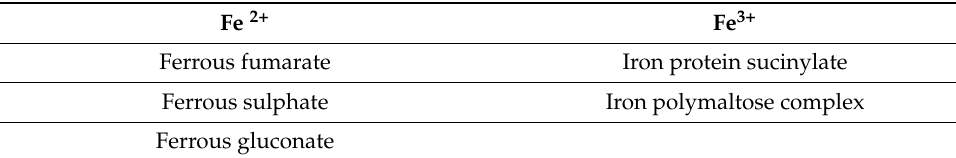
Table 5. Available oral iron formulations [22,57,59].